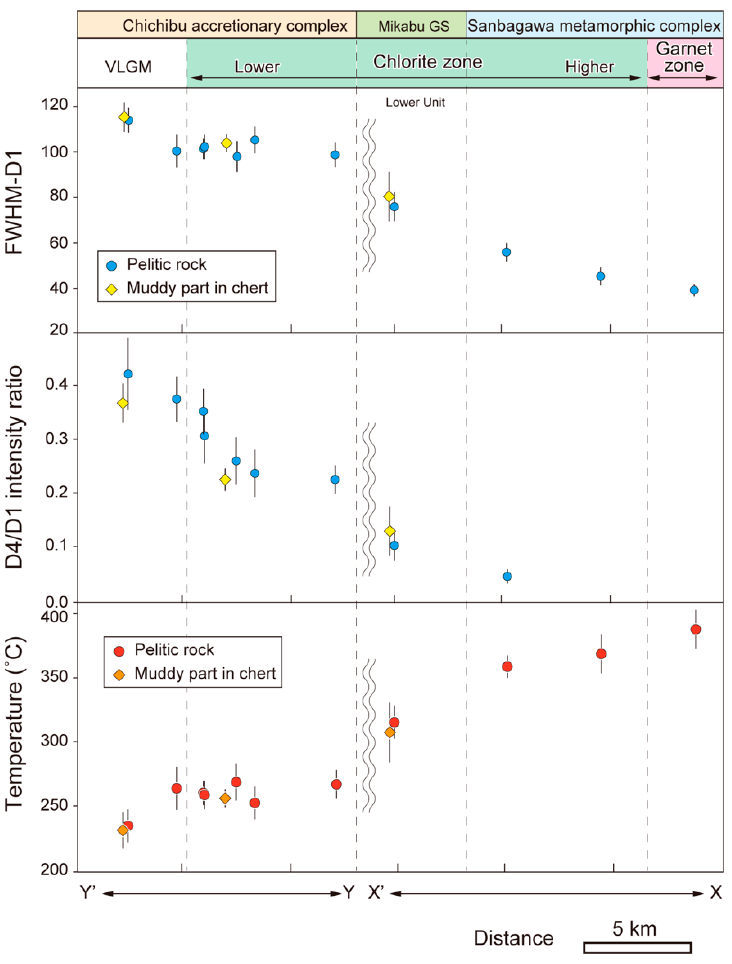
Figure 5. Calculated Raman spectra FWHM-D1 values, D4/D1 intensity ratios, and estimated metamorphic temperatures from pelitic rocks and muddy part in chert along geological transects X–X’ and Y–Y’ through the study area (see Figure 1b for the locations of the transects). GS: greenstones; VLGM: very low-grade metamorphism.